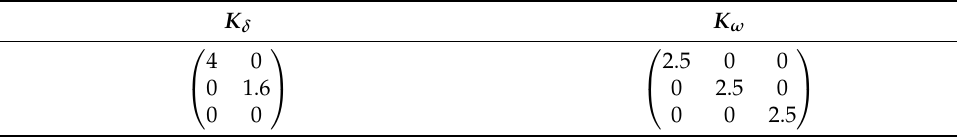
Table 5. Position-based control parameters.